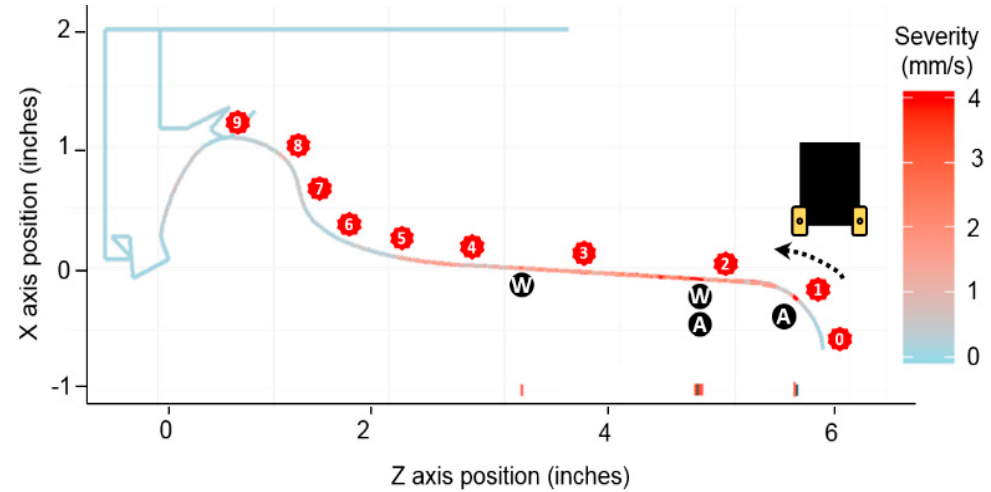
Table 4. Algorithm action sequence.